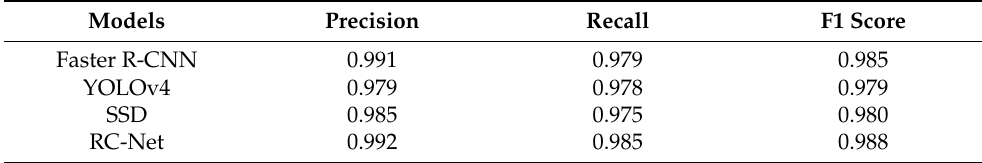
Table 2. Comparison of different rail surface detection models.